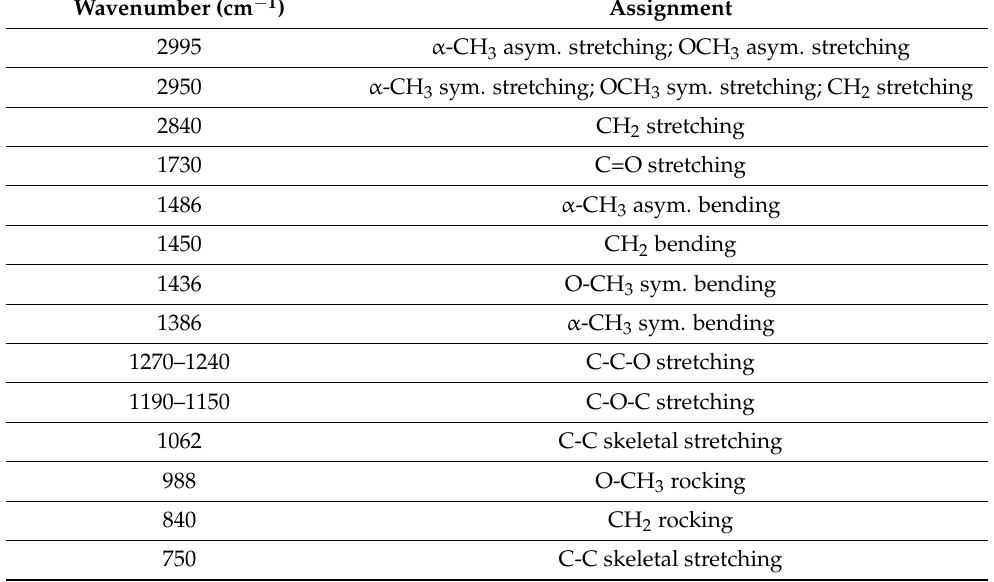
Table 1. Assignment of FT-IR bands in pristine